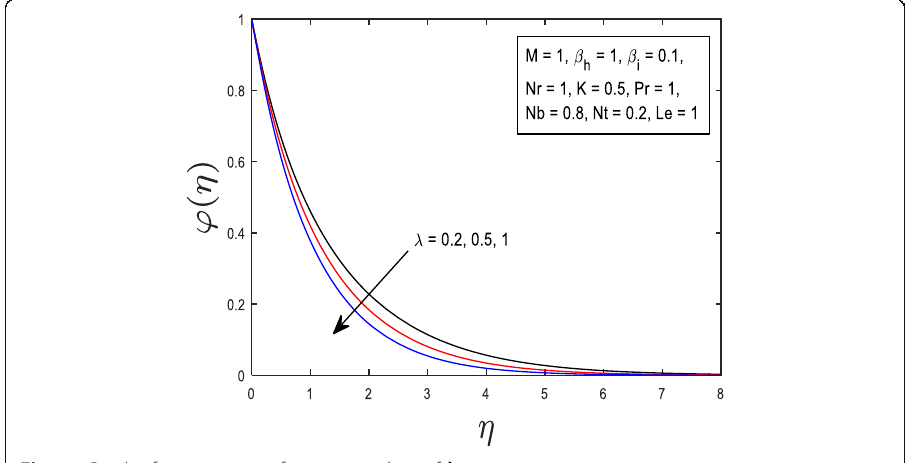
Fig. 14 Graph of concentration for various values of